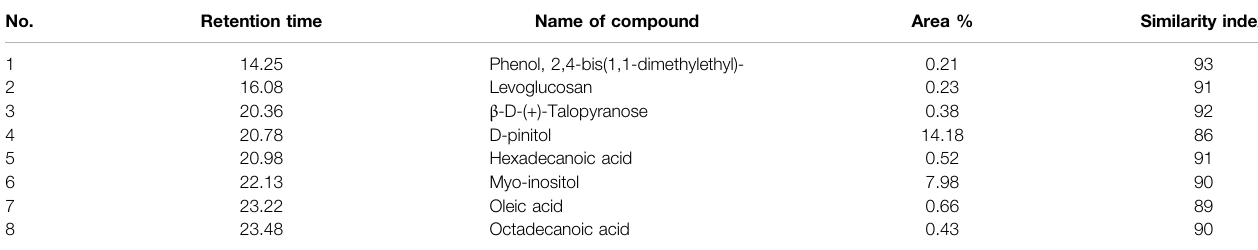
TABLE 1 | Putative compounds in NC leaves ’ extract identi fi ed by